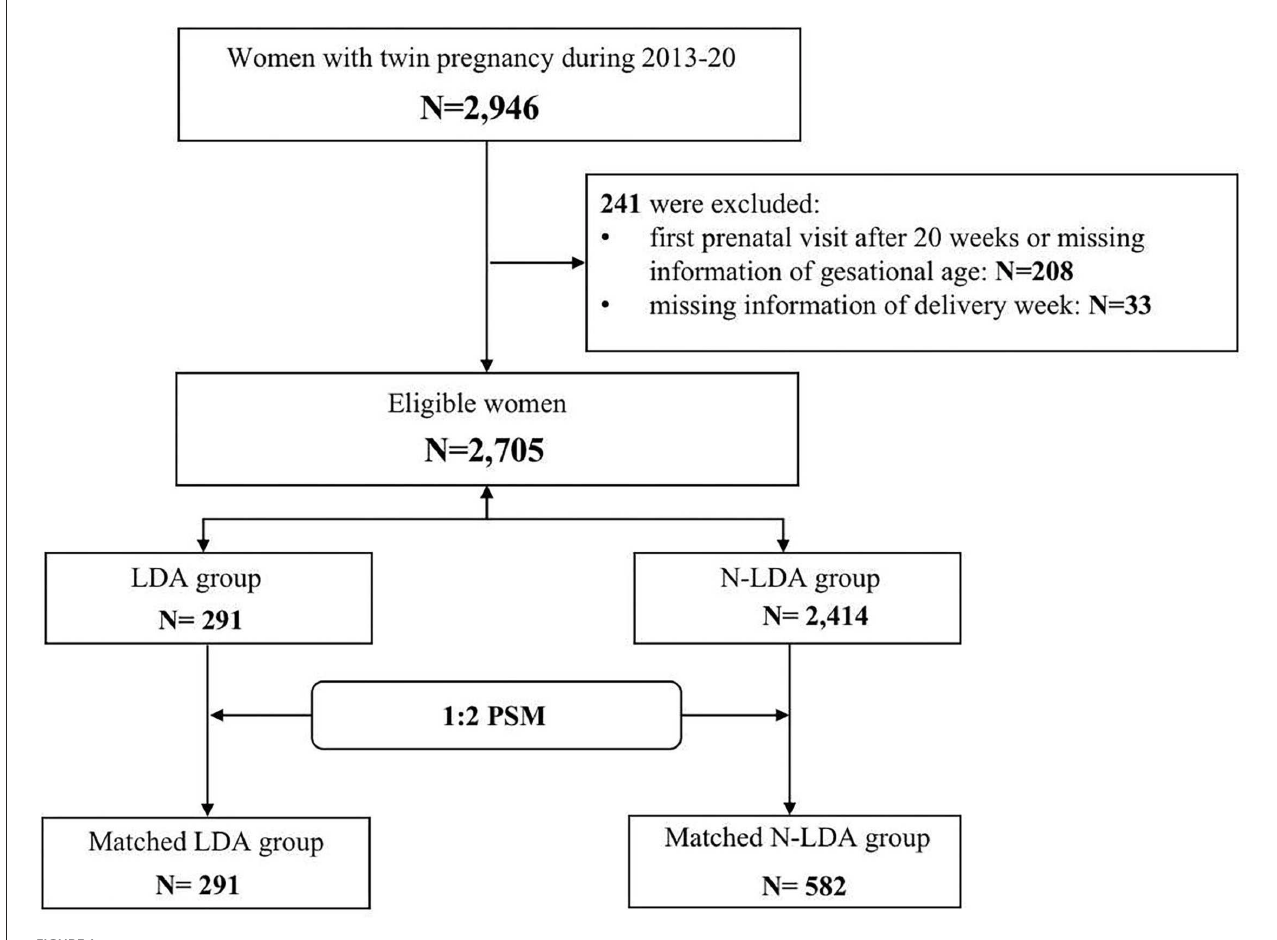
FIGURE1 A flow diagram of the selection of